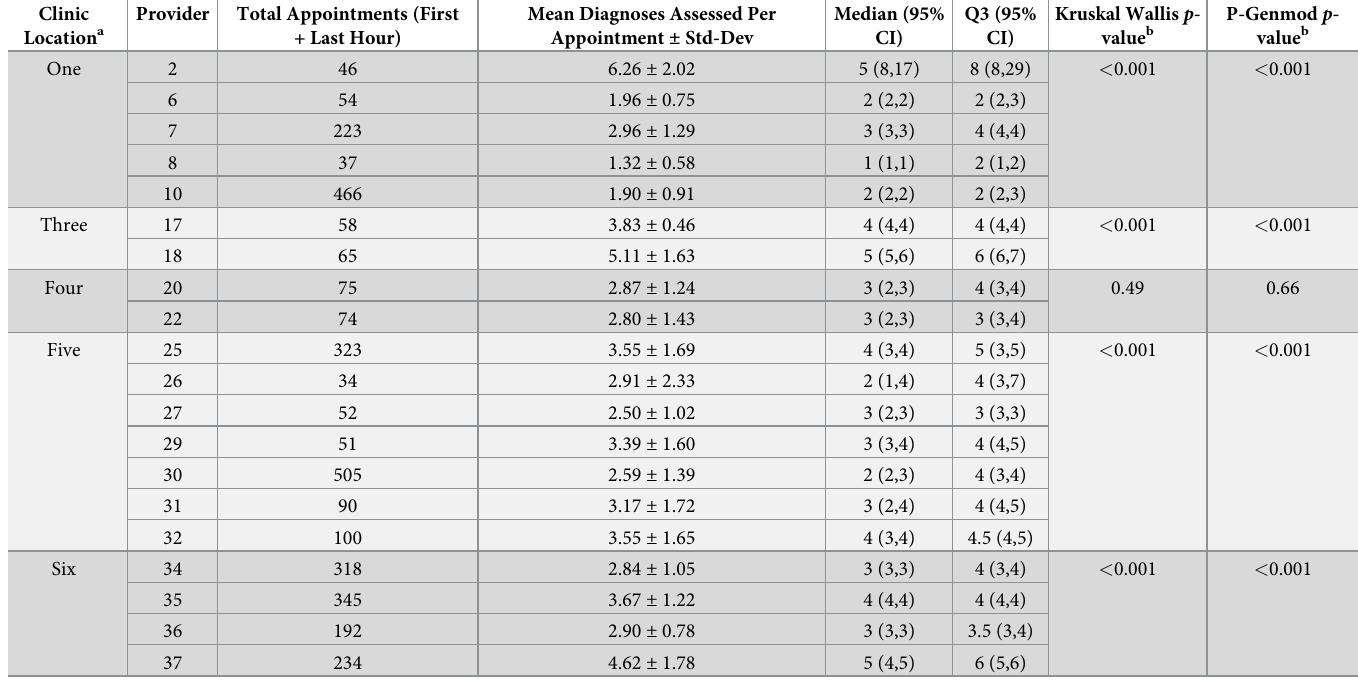
a Each Clinic Location represents a specific specialty. b For within-clinic equality of